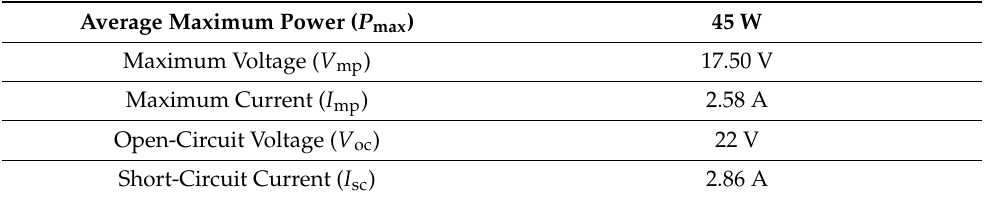
Figure 7. Mismatch scenarios and results: ( a ) Mismatch scenarios (scenario 1: when SM1 and SM2 is producing Scheme 2. when SM1 producing lower than SM2 , and scenario 3: when SM2 is producing lower than SM1 ), ( b ) Mismatch current ( I L ) passing through the inductor L under various mismatch scenarios in Figure 7a.